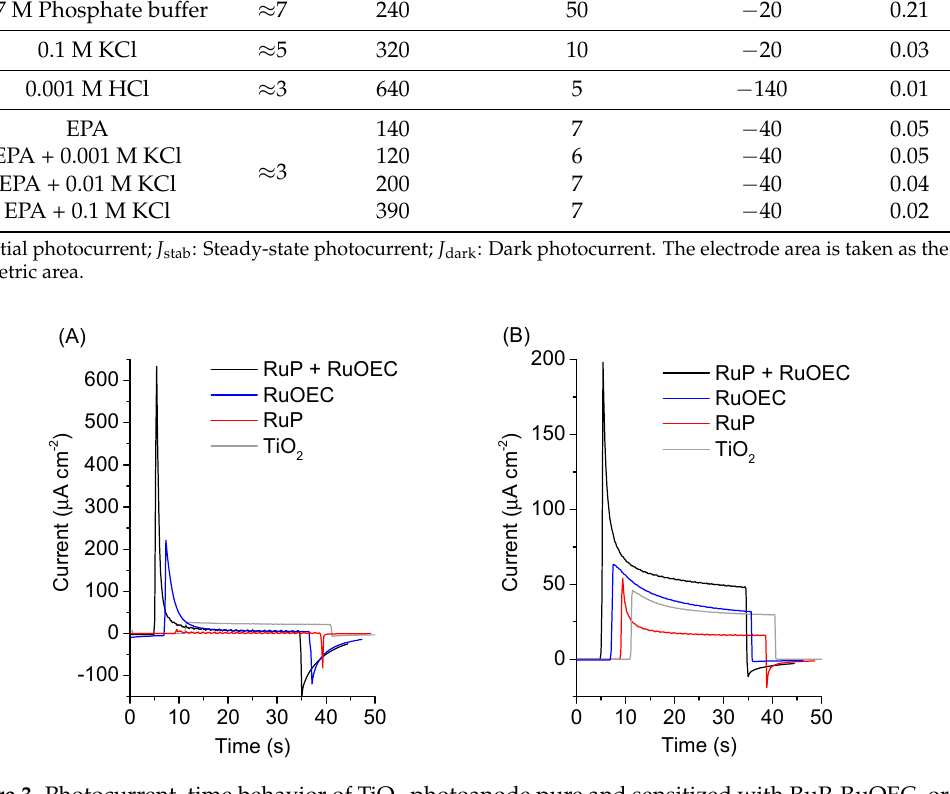
Figure 3. Photocurrent–time behavior of TiO 2 photoanode pure and sensitized with RuP, RuOEC, or RuP + RuOEC in ( A ) HCl (pH ≈ 3) and ( B ) 0.07 M phosphate buffer solution (pH ≈ 7). The photoanodes were biased at 0.236 V vs. normal hydrogen electrode (NHE).